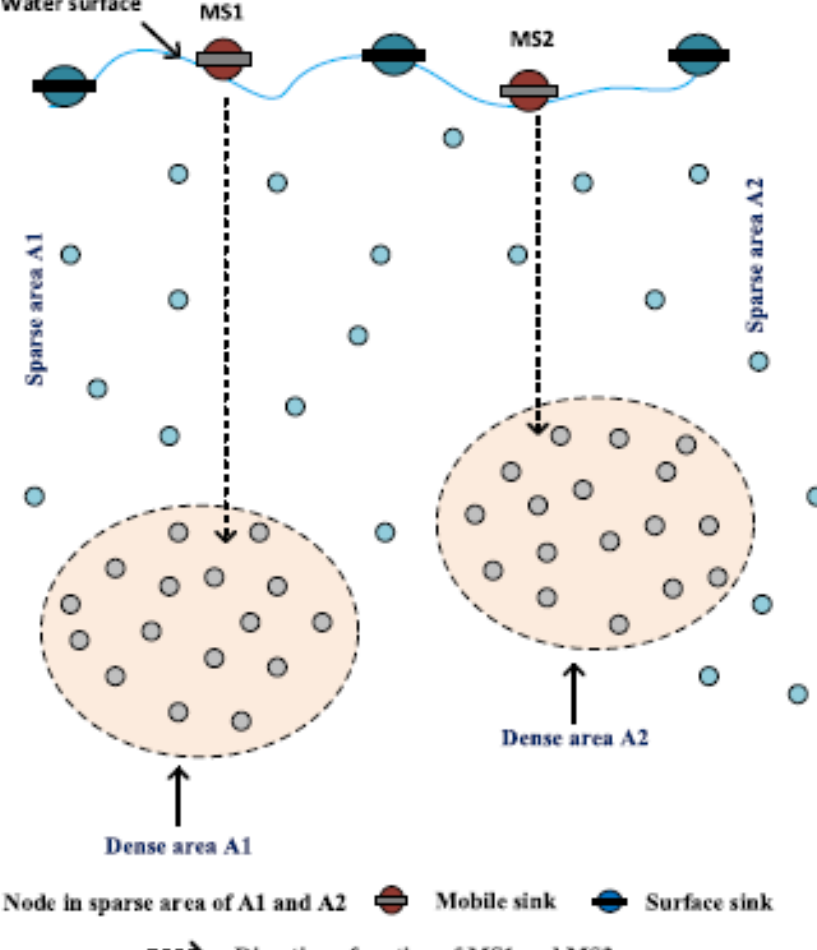
Figure 17. Sink mobility model